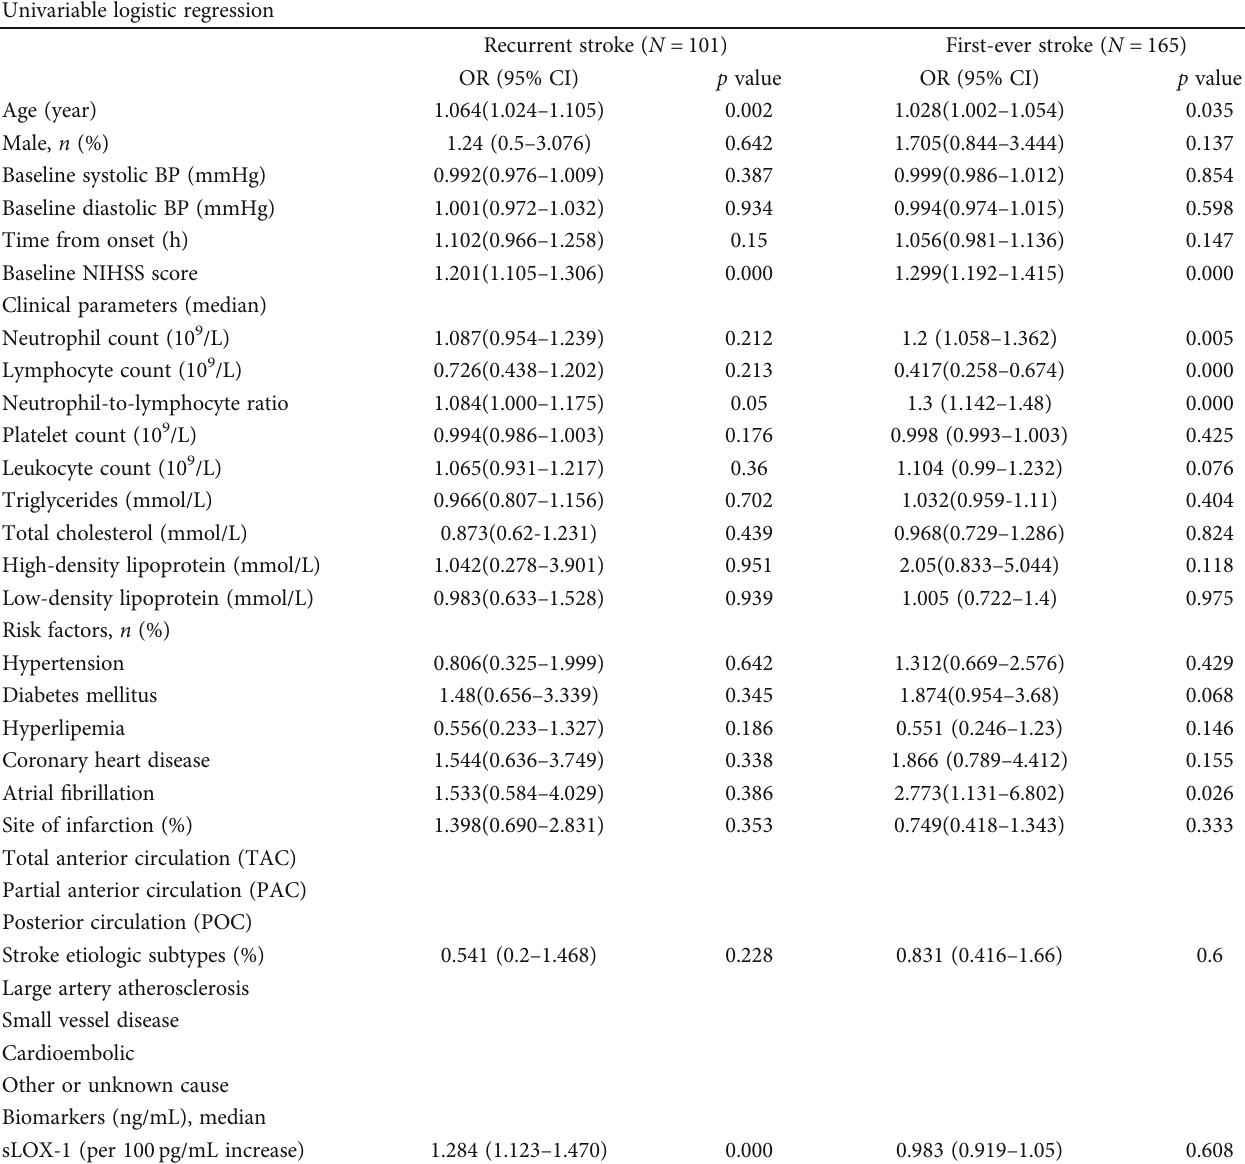
Table 2: Univariate logistic regression analyses for favorable outcome in patients with fi rst-ever and recurrent stroke. Univariable logistic